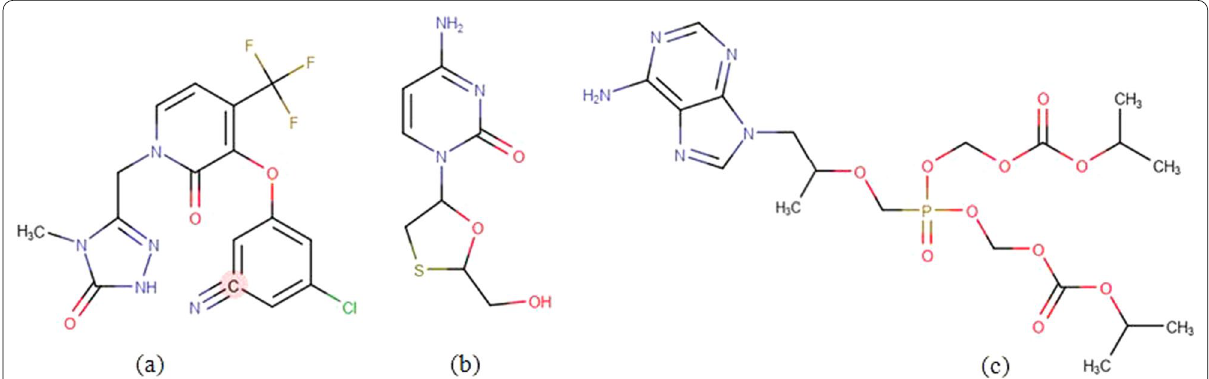
Fig. 1 Chemical structures of a Doravirine, b Lamivudine and c Tenofovir disoproxil